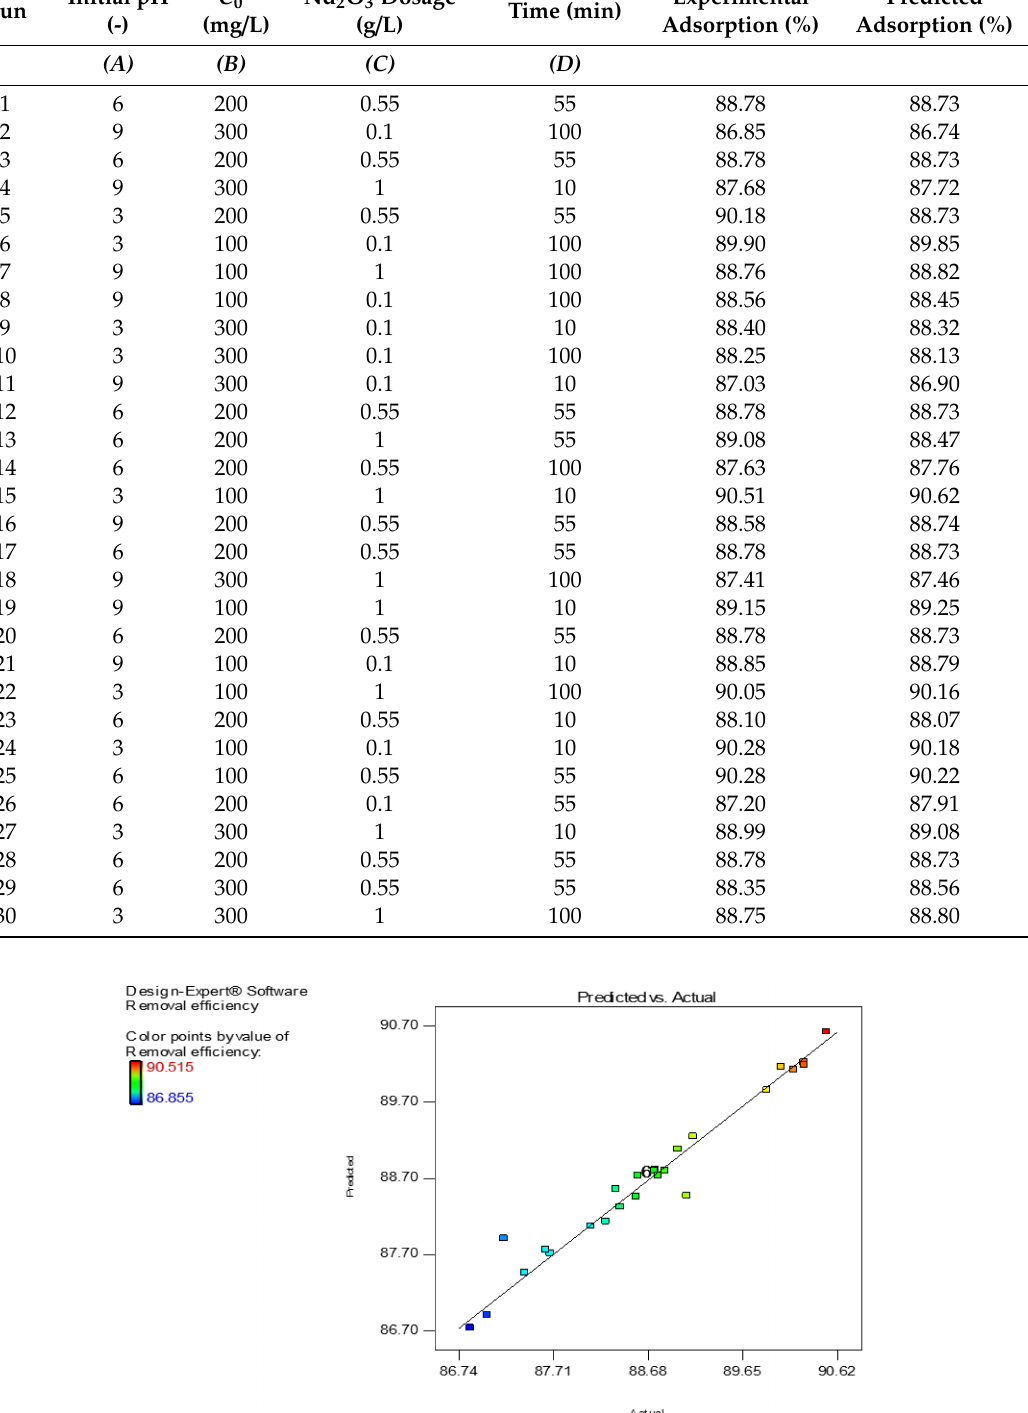
Figure 6. Predicted values versus experimental (actual) values of AB92